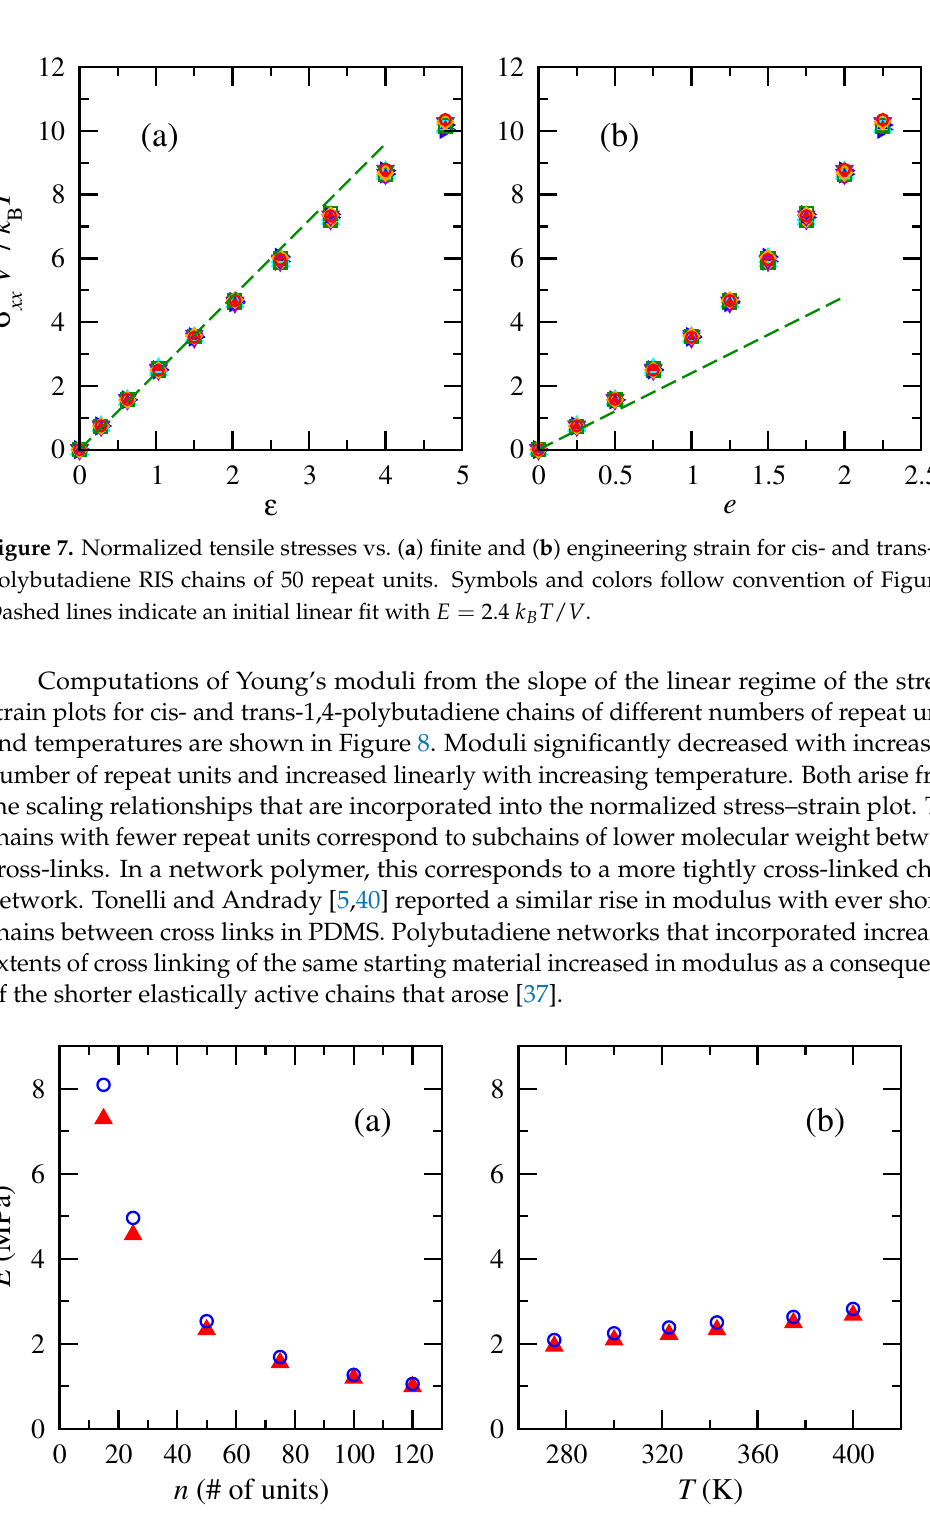
Figure 8. Tensile or Young’s moduli of cis- and trans-1,4-polybutadiene RIS chains of ( a ) different numbers of repeat units at 343 K and ( b ) different temperatures for 50 repeat units. Numerical model results: cis ( (cid:78) red); trans ( ◦